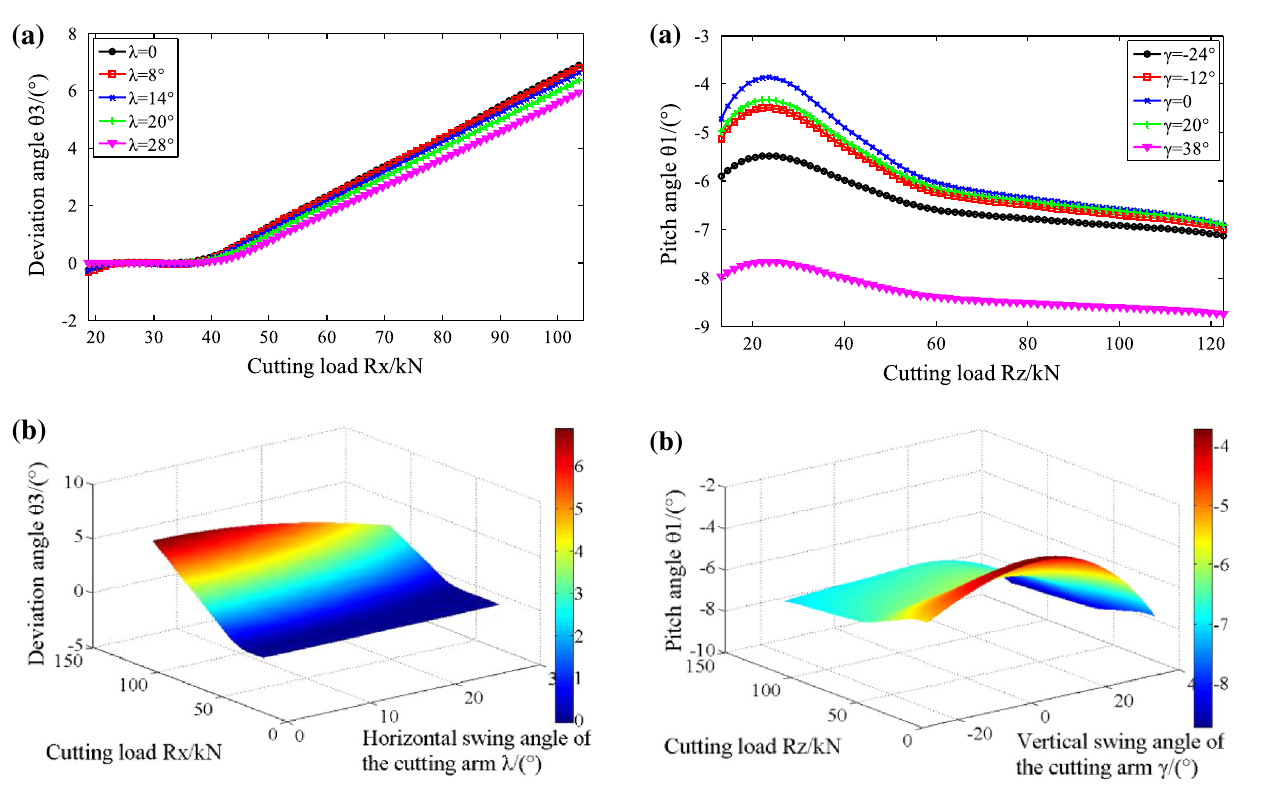
Fig. 13 Response regularities of the pitch angle during the vertical cutting process. ( a ) Relationship between the pitch angle and the cutting load; ( b ) Relationship of the pitch angle, cutting load and vertical swing angle of the cutting